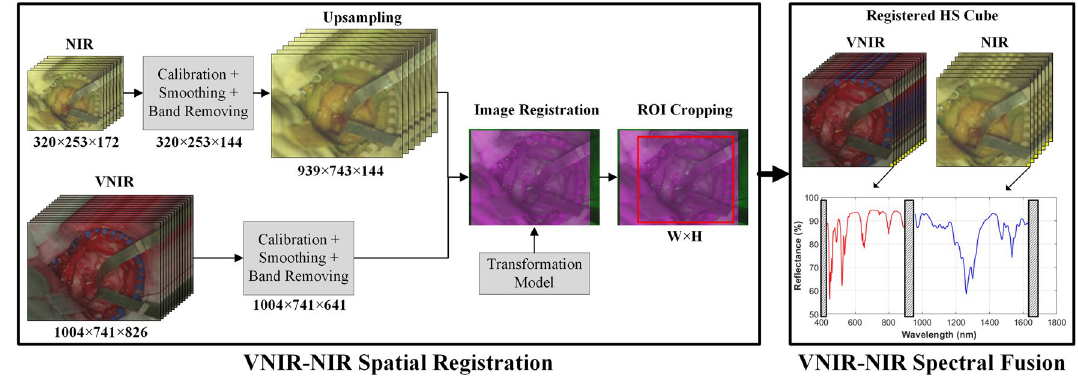
Figure 5. Block diagram of the proposed processing framework based on VNIR–NIR spatial registration combined with spectral fusion. NIR: Near-Infrared; VNIR: Visual and Near-Infrared; ROI: Region of Interest; W: Width; H: Height; HS: